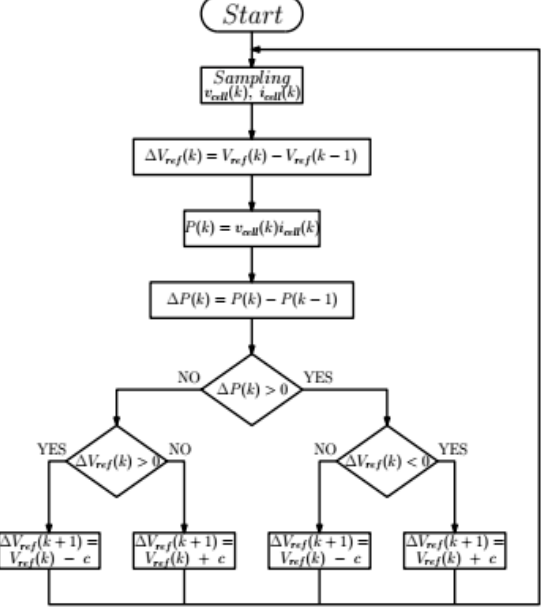
Figure 3. Perturb and observe (P&O) algorithm.